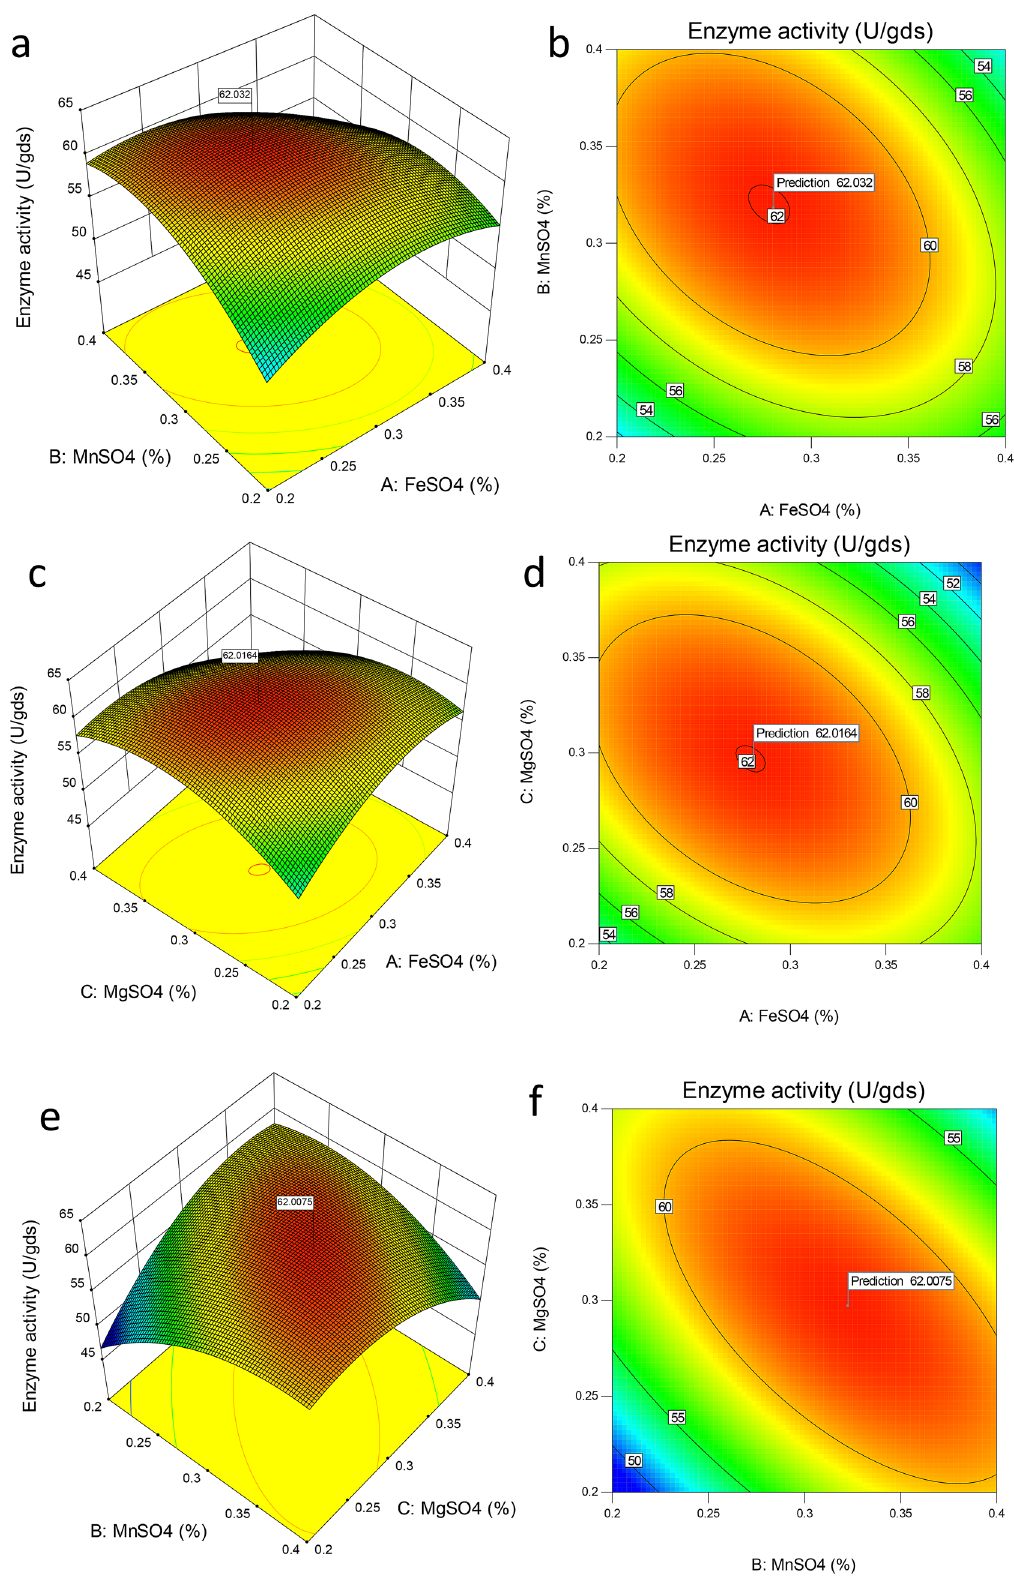
Figure 3. ( a – f ) Showing the effect of nutrients supplemented in green gram husk for pullulanase